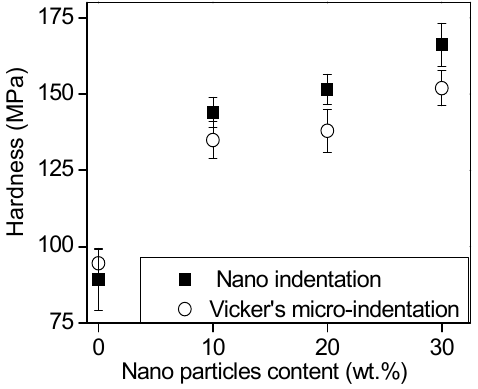
Figure 5. Hardness comparison between results from nanoindentation and Vickers hardness tests.